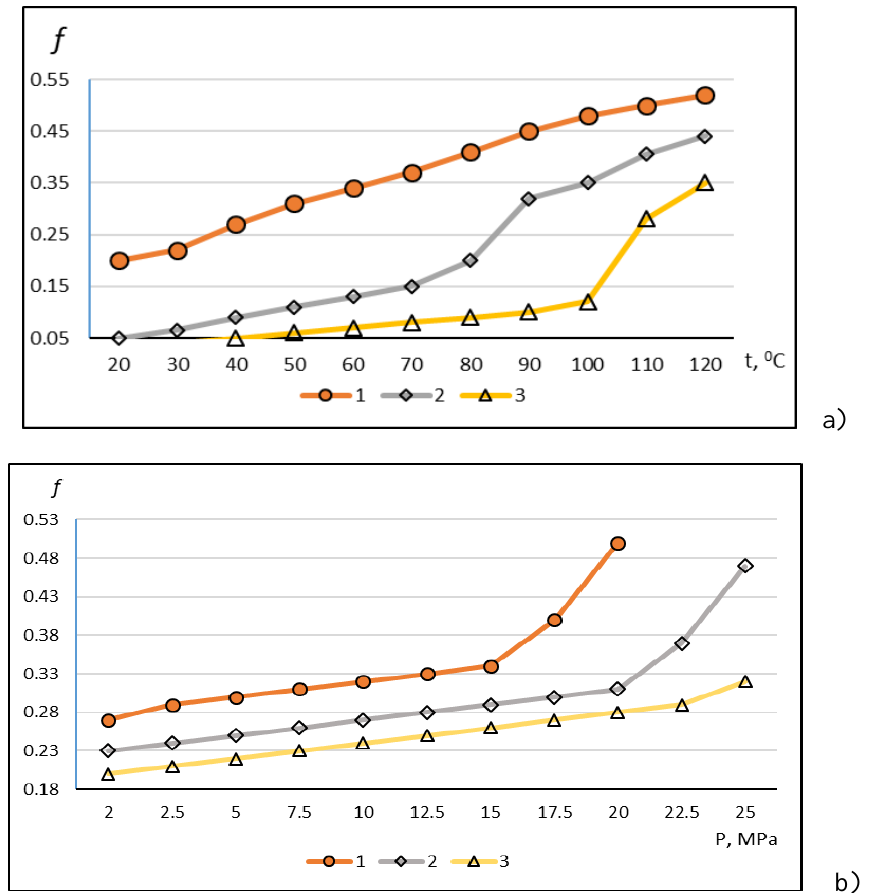
Fig. 3. Dependence of coefficient of friction on temperature at contact load of 7,5 MPa (а) and on the specific load on plain bearing (V = 0,78 m/s; Δ= 0,3 mm, = 50 0 С) (b): 1 - pure polyamide (Ertalon 4.6); 2, 3 - polyamide filled with metal chips (steel 21864) in concentration of 10 and 20% respectively under the action of magnetic field